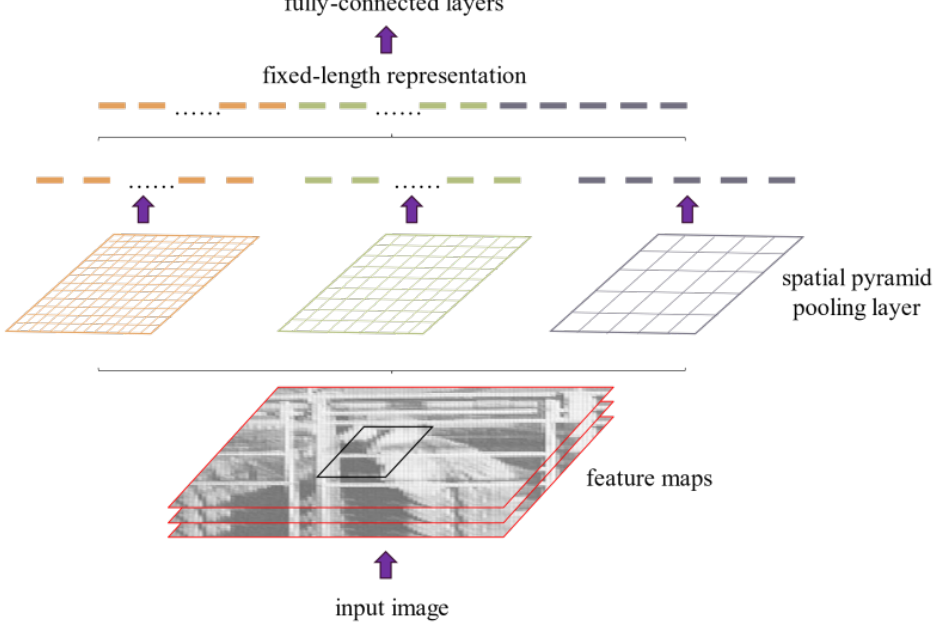
Figure 7. SPP network structure.